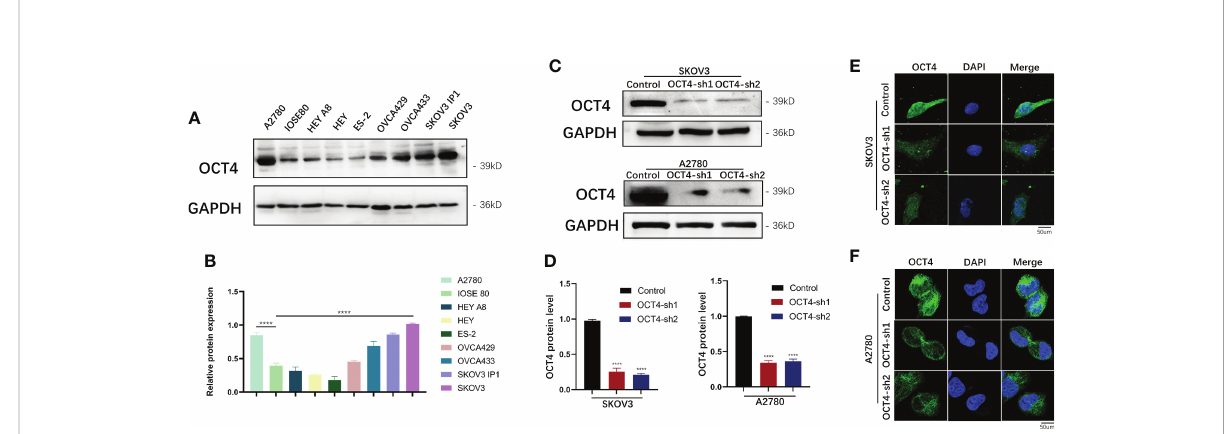
FIGURE 2 Expression of OCT4 in OC cell lines (A, B) OCT4 protein expression in OC cell lines compared with normal ovarian epithelial cell lines (IOSE80). (C, D) OCT4 protein expression in SKOV3 and A2780 cells transfected with shRNAs targeting OCT4 by Western blotting assay. (E, F) The above expression was veri fi ed by IF analysis. (Data were expressed as the mean ± SD. Signi fi cance was calculated using Student's t-test. ****, P<0.0001.)